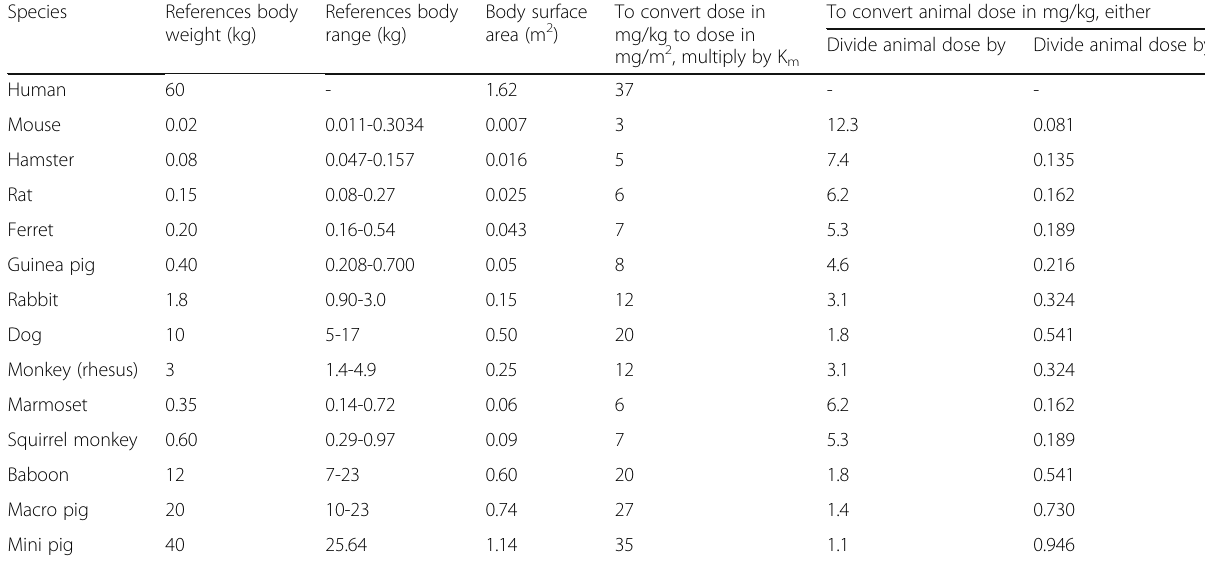
Table 7 Human equivalent dose calculation based on body surface area a